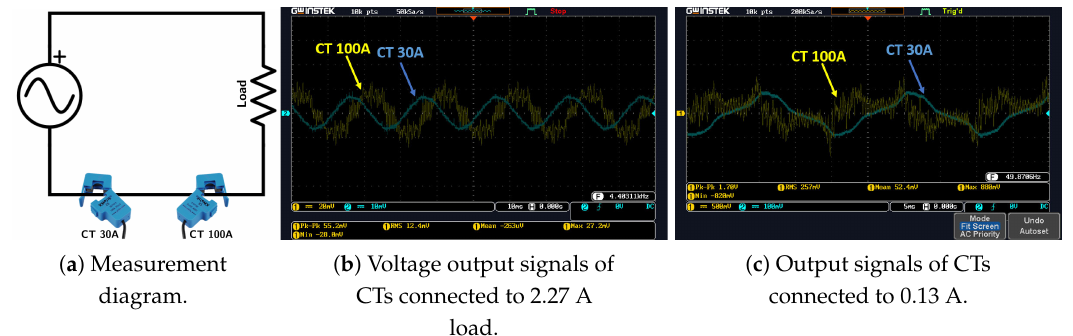
Figure 4. Comparison of Current Transformers (CTs) performance with two low current-demanding